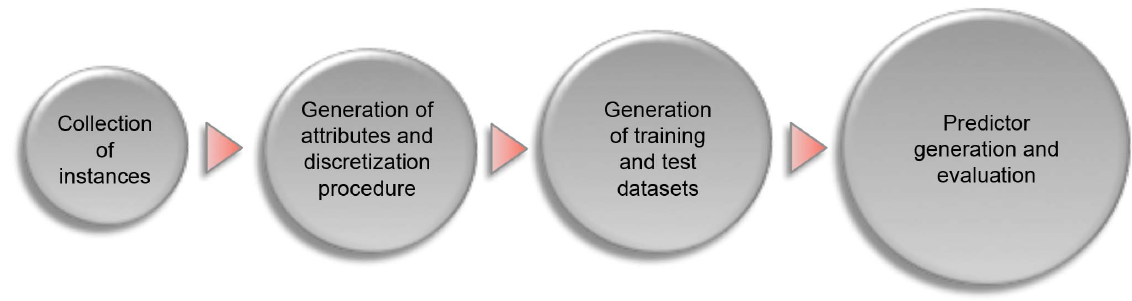
Figure 5. A general workflow of the procedures adopted in this work.